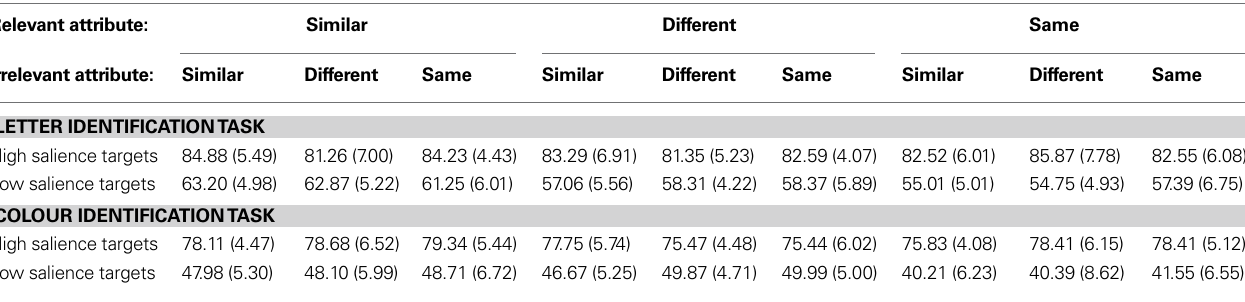
Table 2 | Mean accuracy (%) and normalized standard deviations (in brackets) for each of the bilateral conditions for both the high salience and